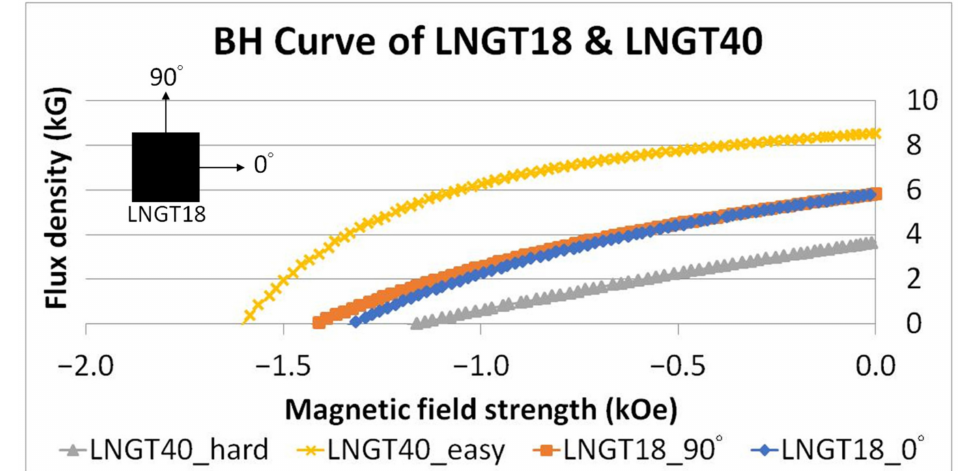
Figure 1. B-H curve of LNGT18 (isotropic) and LNGT40 (anisotropic).